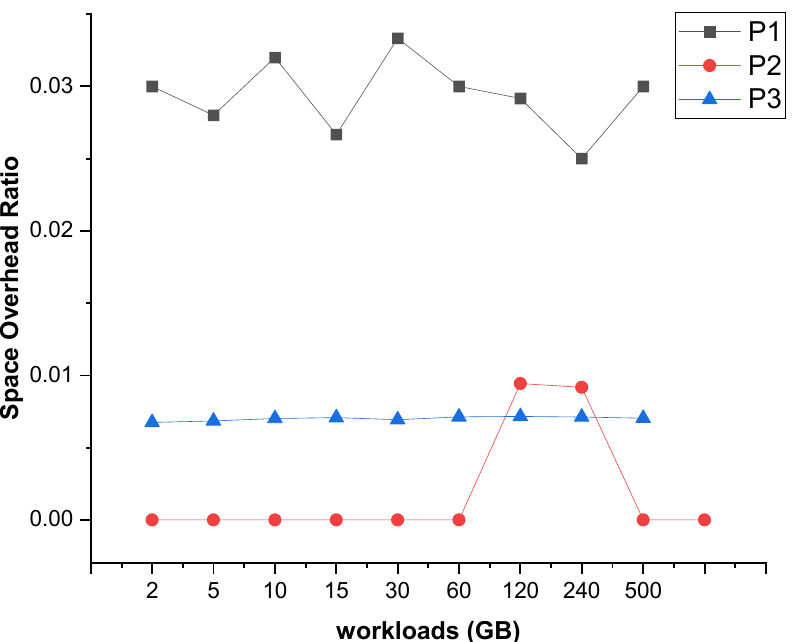
Figure 13. Space overhead ratio results for storing references for P1, P2, and P3 in s2p-flink comparing native Flink under various workloads.